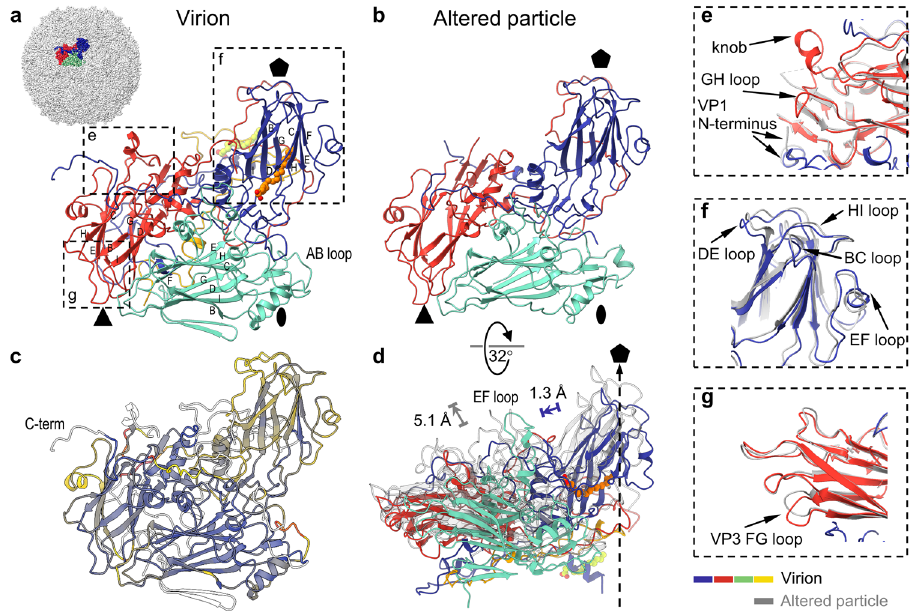
Fig. 2 Structures of icosahedral asymmetric units of CV-A6 virion and altered particle. a Ribbon representation of icosahedral asymmetric unit of CV-A6 virion with VP1 coloured in blue, VP2 in green, VP3 in red, and VP4 in yellow. The relative position of the depicted protomer in the virion is indicated in the inset. Positions of the twofold, threefold, and fi vefold icosahedral symmetry axes are indicated with an oval, triangle, and pentagon, respectively. The pocket factor (stearic acid) and the putative myristate attached to the N-terminus of VP4 are shown as ball-and-stick models in orange and yellow-green, respectively. Beta-strand identi fi ers of the jelly roll CHEF and BIDG sheets are indicated. The dashed rectangles highlight the structural details shown in e – g . b Icosahedral asymmetric unit of altered particle, shown in same orientation as in a . c Structural deviations between virion and altered particle. R.m.s. deviations are mapped onto the protomer of the virion. Regions of low deviation (r.m.s.d. ≤ 3 Å) are coloured in blue, through yellow ( ≤ 4 Å), to orange ( ≤ 6 Å) and dark red (>6 Å). Chain segments missing in the altered particle are coloured white. d Side view of the protomers from virion and altered particle. In the virion, the centre of mass of the jelly roll core of VP1 is shifted 1.3 Å closer to the centres of mass of VP2 and VP3 than in the altered particle. Upon expansion, the centre of mass of the altered particle protomer shifts by 5.1 Å. The centre of mass of the virion was calculated using an equivalent subunit and amino acid selection that matches the protomer of the altered particle. e – g Details of major structural differences between virion and altered particle. The virion protein chains are shown in colours, those of the altered particle in